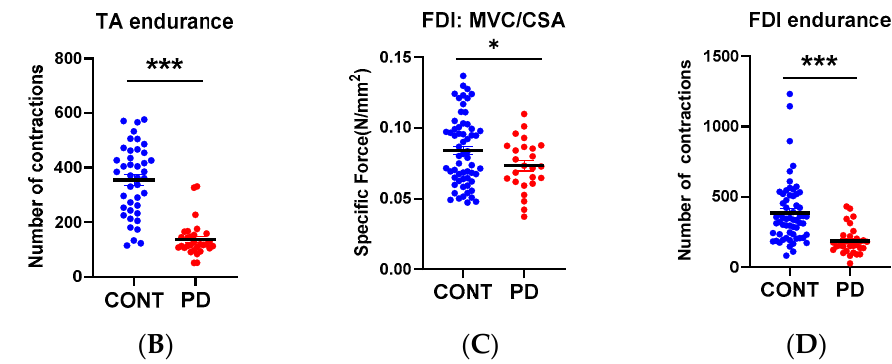
Figure 4. Muscle function in leg (TA) and hand (FDI). Comparison of muscle function between control and subjects with Parkinson’s disease. Muscle specific force in the ( A ) TA and ( C ) FDI; Muscle endurance measured as number of voluntary muscle contractions in the ( B ) TA and ( D ) FDI. * p < 0.05, ** p < 0.01, *** p < 0.0001.